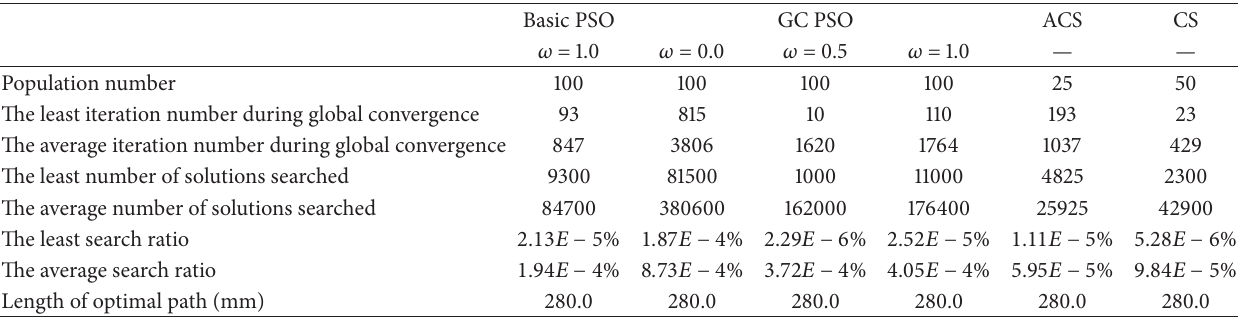
Table 6: Performance comparison of CS with variants of PSO and ACS on workpiece 2. Basic